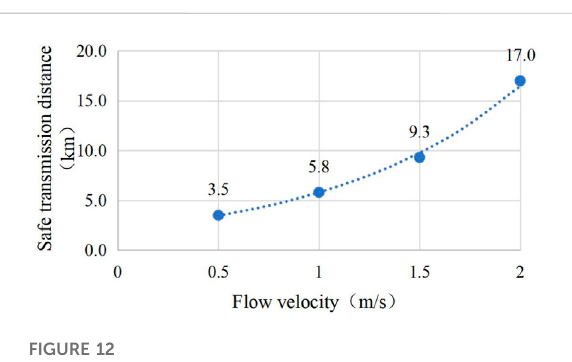
FIGURE 12 Relationship between safe transmission distance and design